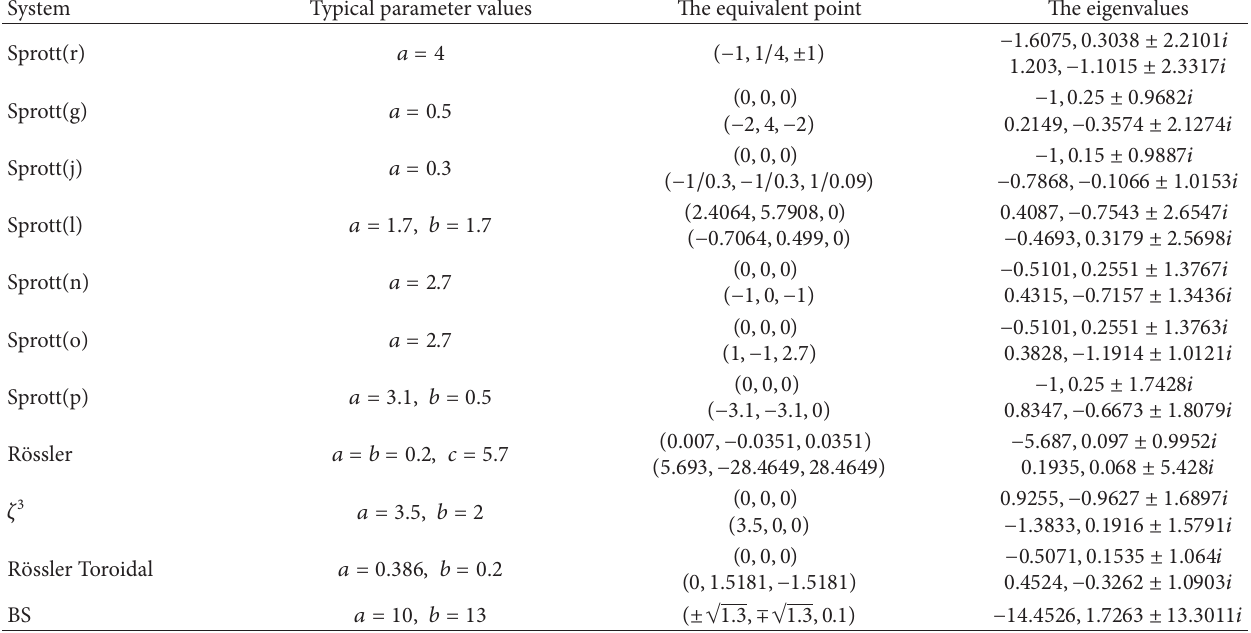
Table 2: The systems with two equilibrium